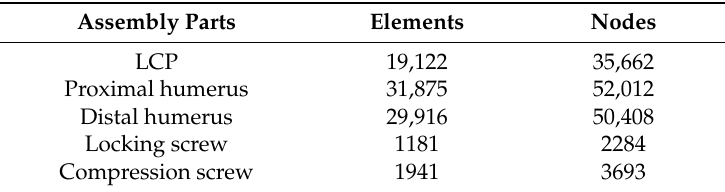
Table 2. Mesh statistics for individual parts.